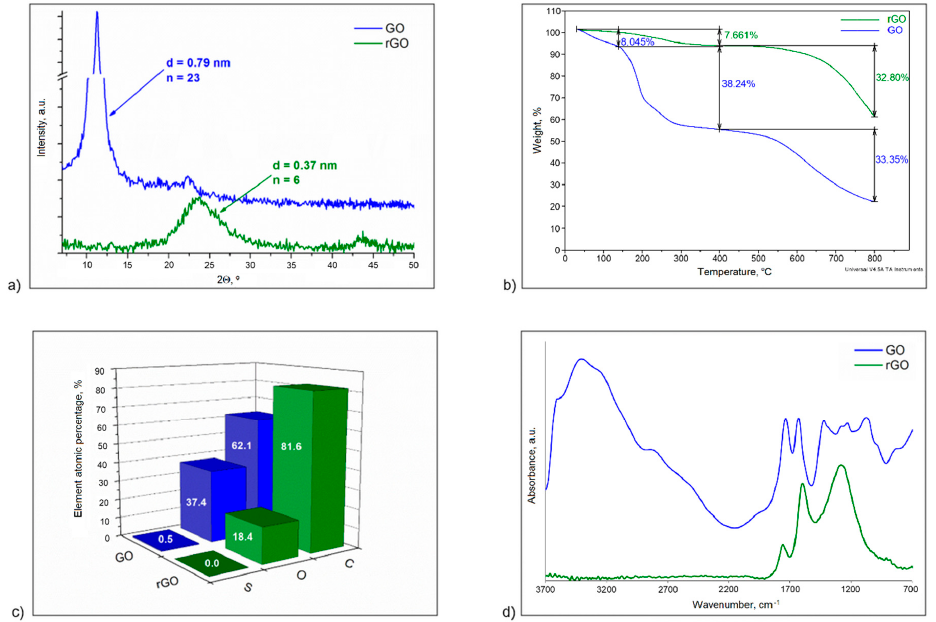
Figure 1. Characterisation of graphene oxide and reduced graphene oxide: ( a ) WAXS patterns (d—interlayer distance, n—average number of layer); ( b ) TG curves; ( c ) EDS analysis; ( d ) FTIR spectra.